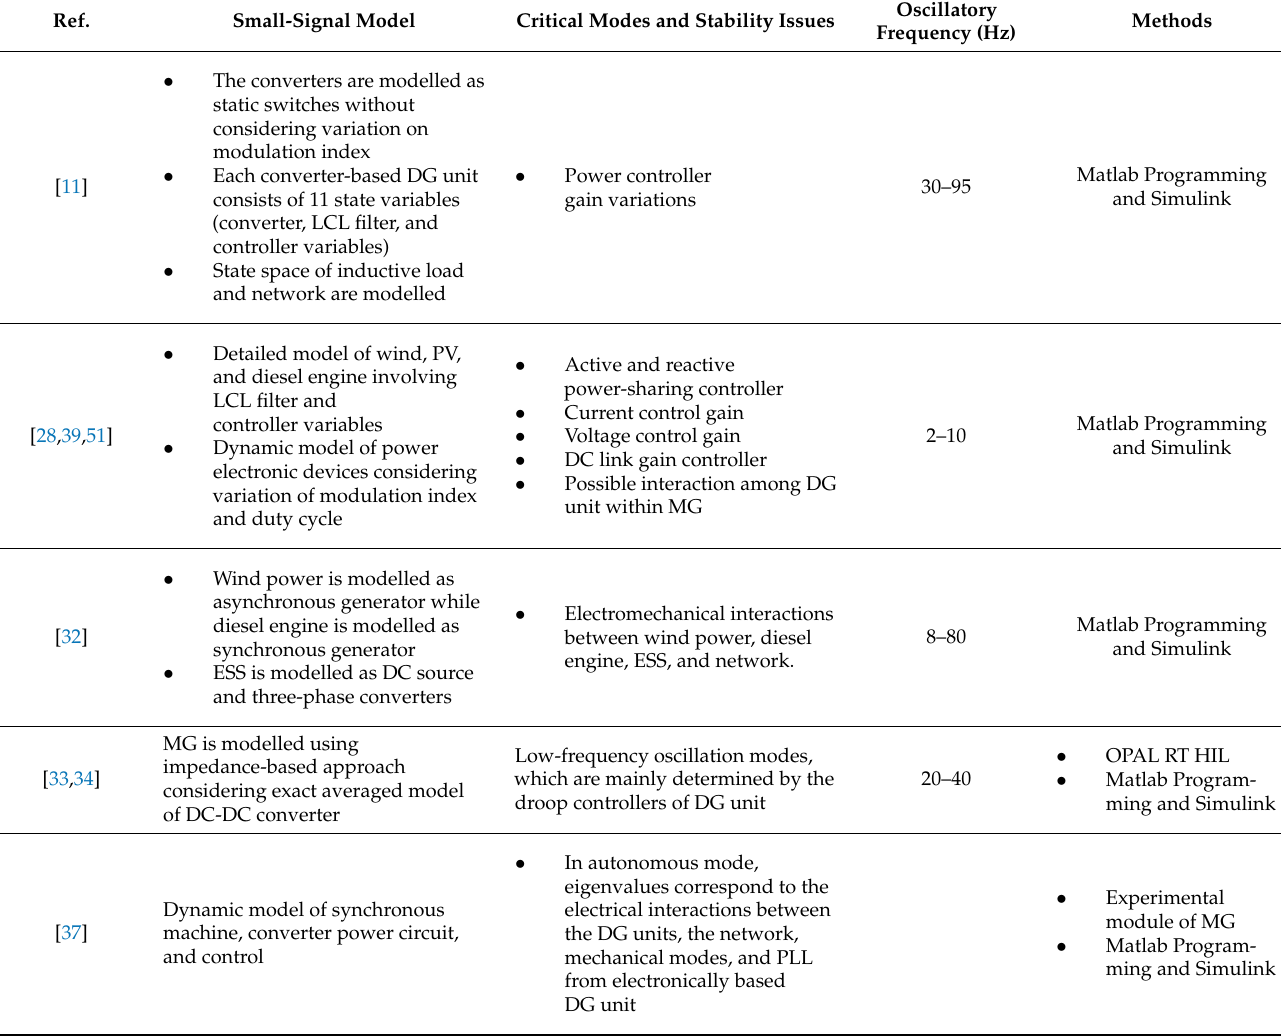
Table 3. Overview of small-signal stability in